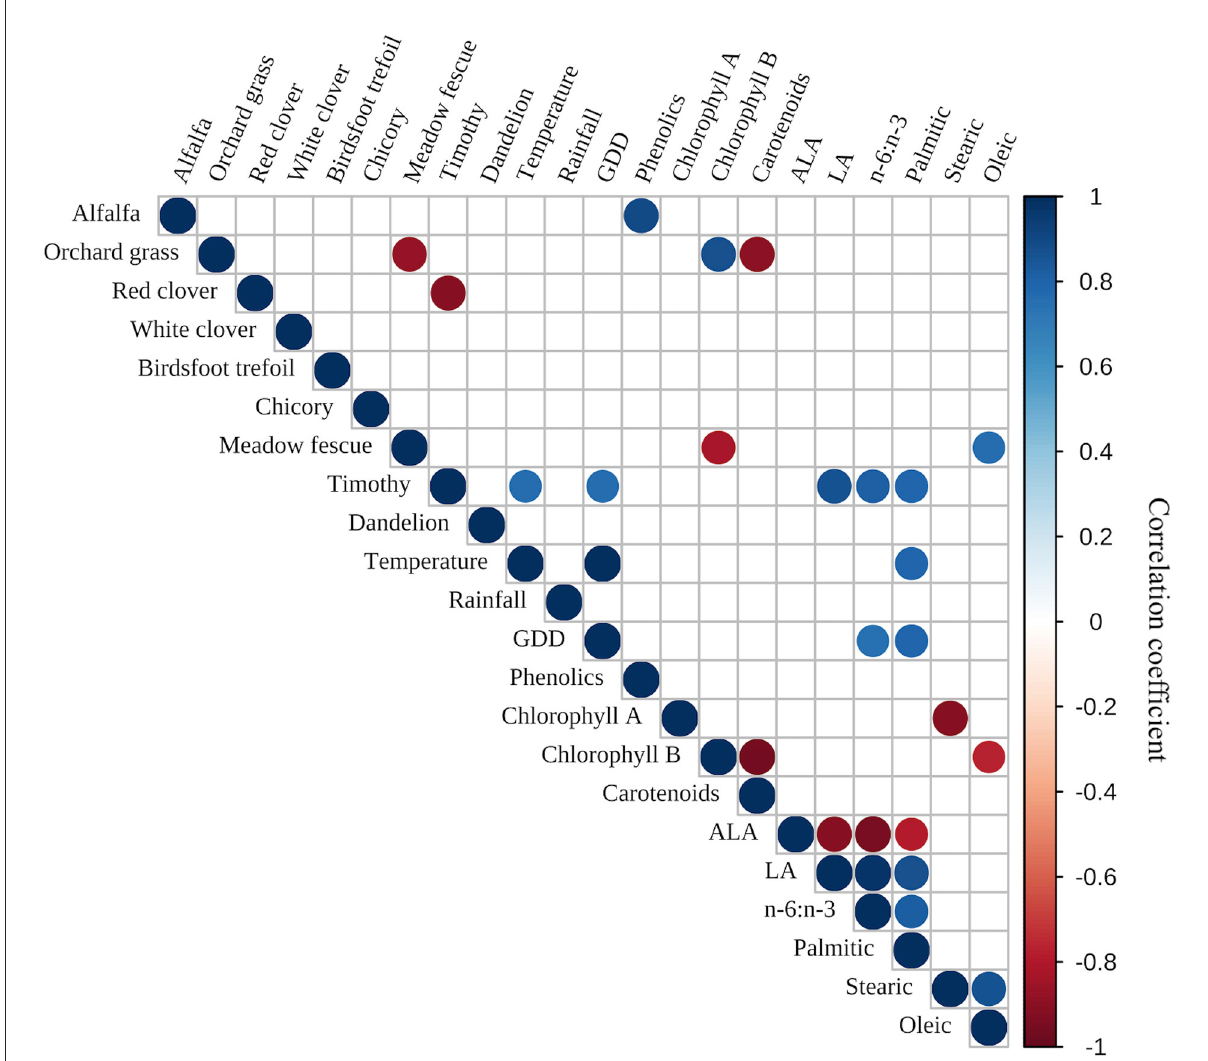
FIGURE3 Pearson correlations between individual plant species, weather, and selected fatty acids a . a Pearson correlation matrix displays r correlation coefficients represented as circles. Blue shades denote positive r correlation coefficients, while red shades denote negative r correlation coefficients. Only results with P < 0.05 are displayed, thus, empty boxes were not significant. ALA, alpha-linolenic acid; GDD, growing degree days; LA, linoleic